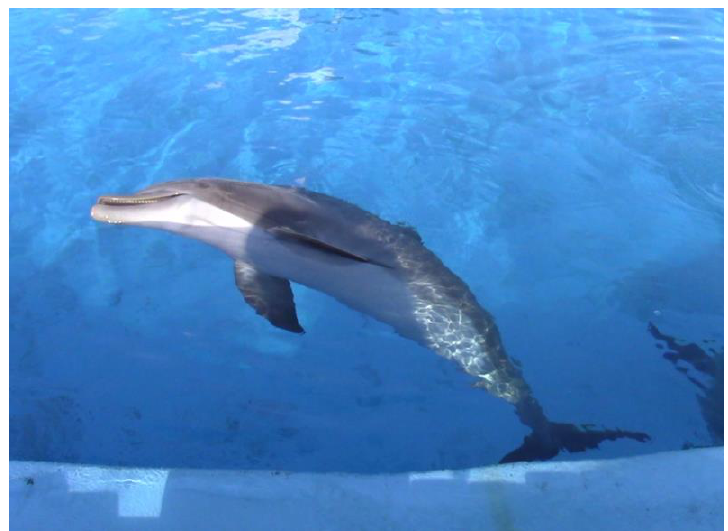
Figure 6. Immobility (IM) behavior, lateral with eyes closed and mouth slightly open.